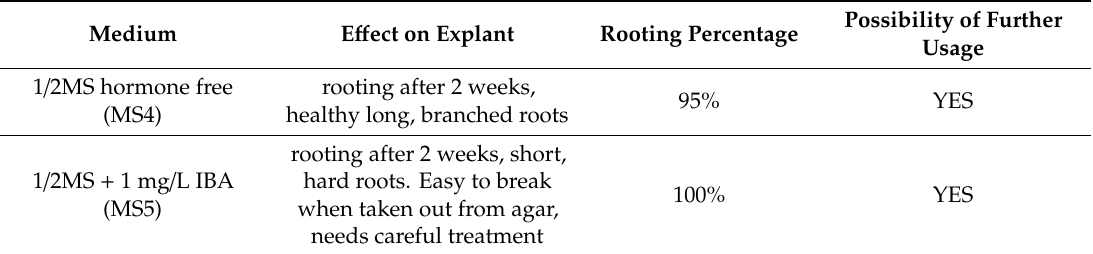
Table 4. E ff ect of di ff erent medium on rooting of P. tomentosa × P. fortunei.